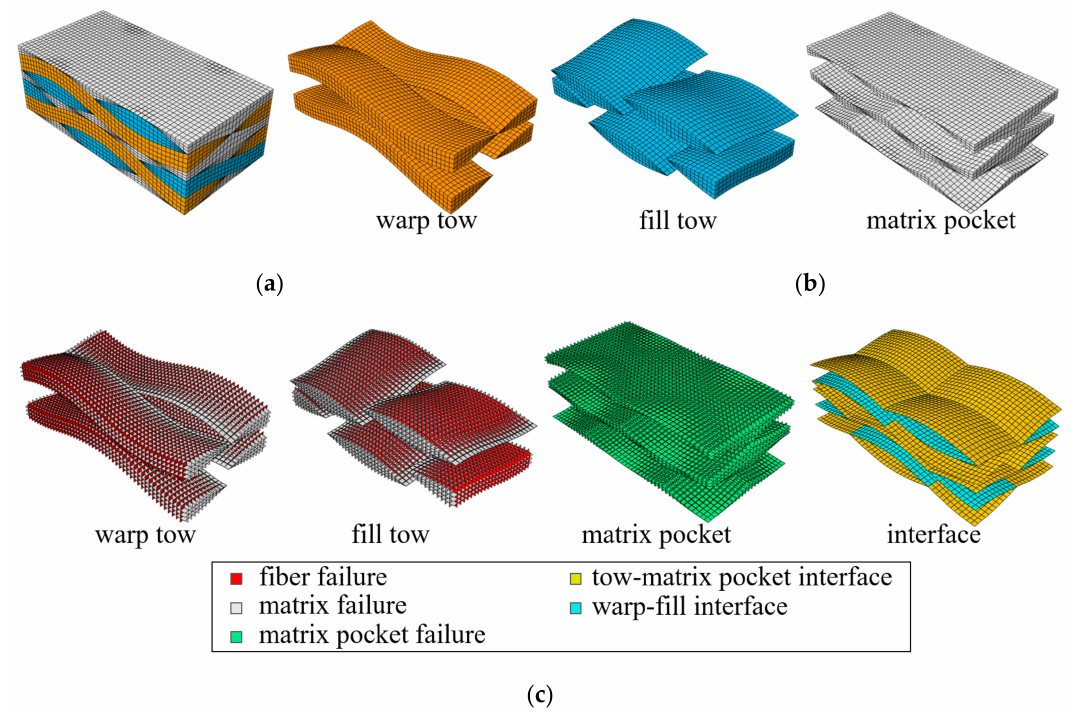
Figure 6. Finite element mesh of two-ply repeating 1/2-unit cell: ( a ) 1/2-unit cell mesh (bulk and cohesive elements); ( b ) bulk elements; and ( c ) cohesive